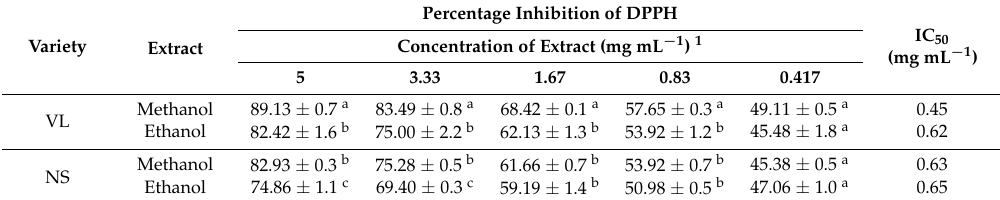
Table 4. Percentage inhibition of 2,2-diphenyl- L -picrylhydrazyl (DPPH) by extracts of fruit